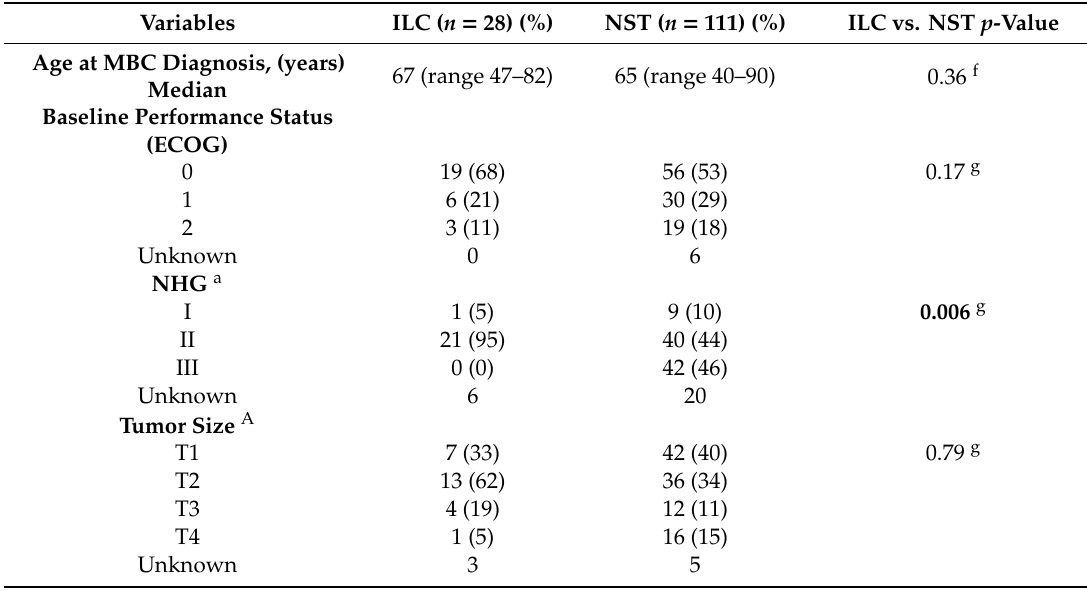
Table 1. Baseline patient and tumor characteristics by histopathological